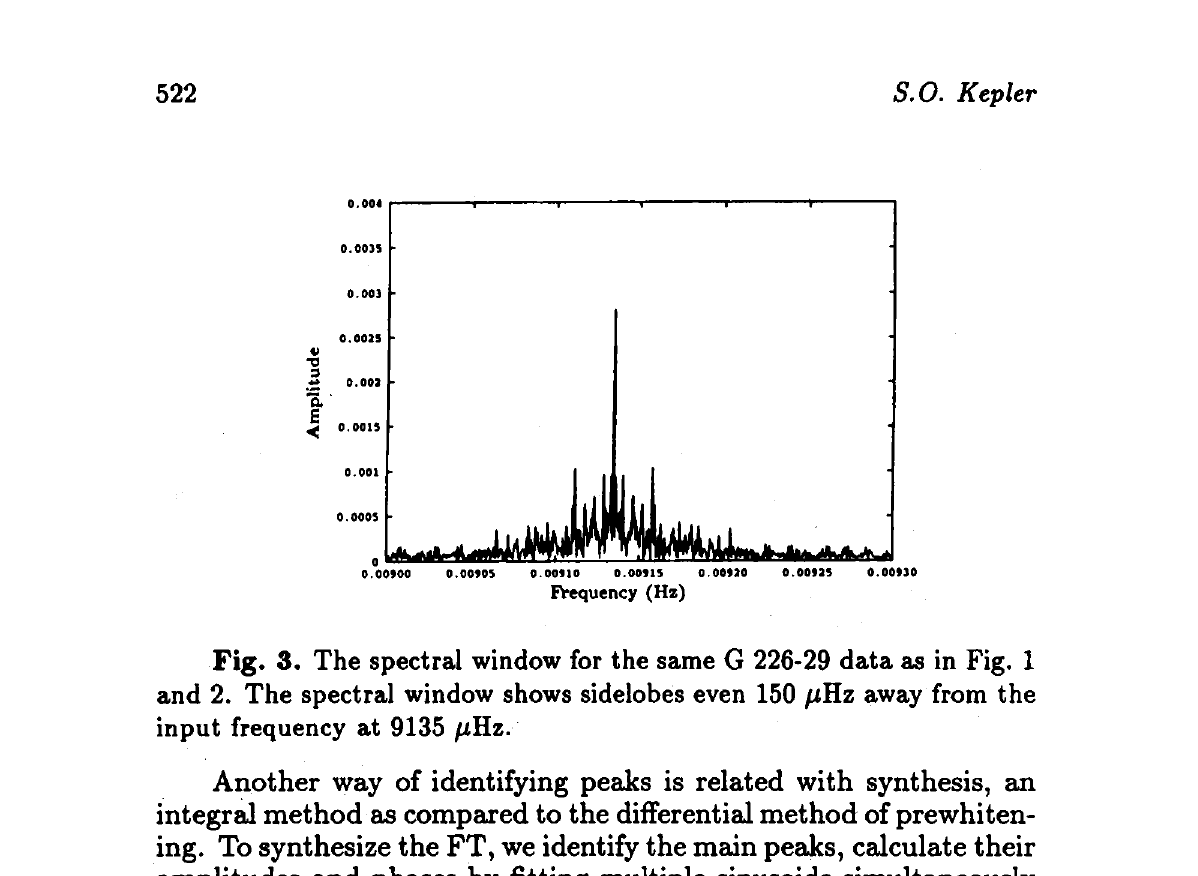
Fig. 3. The spectral window for the same G 226-29 data as in Fig. 1 and 2. The spectral window shows sidelobes even 150 ¿tHz away from the input frequency at 9135 fx